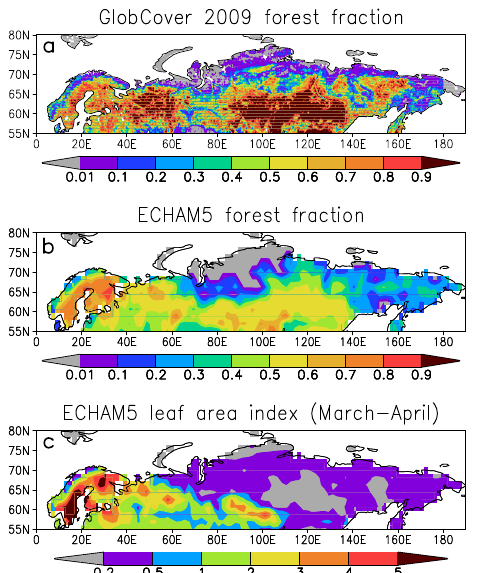
Figure 7. (a) Forest fraction in the GlobCover 2009 land cover map (computed as the sum of land cover classes 40, 50, 60, 70, 90 and 100). (b) Forest fraction assumed in the ECHAM5 simulations. (c) Leaf area index assumed in the ECHAM5 simulations, averaged over March and